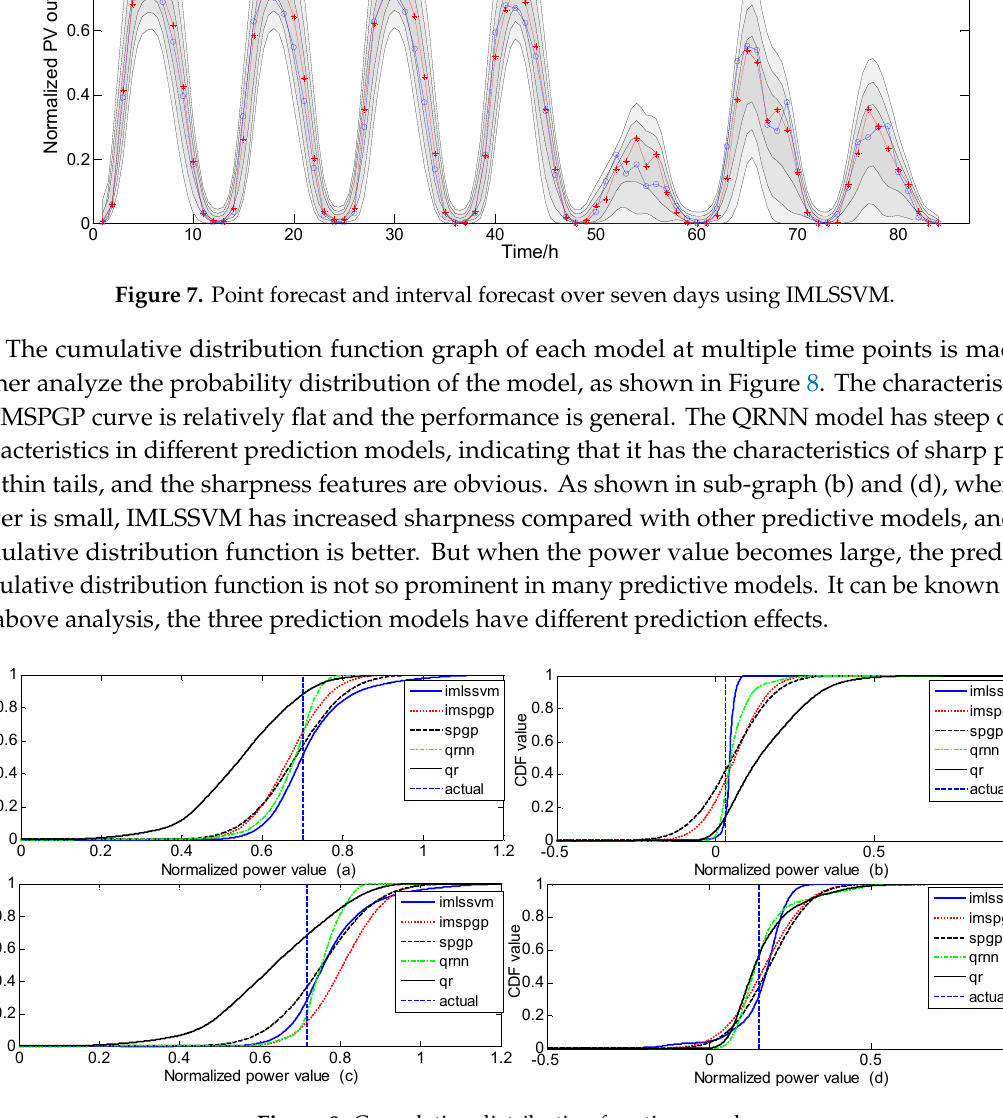
Figure 6. Comparison of error probability density functions in different intervals.